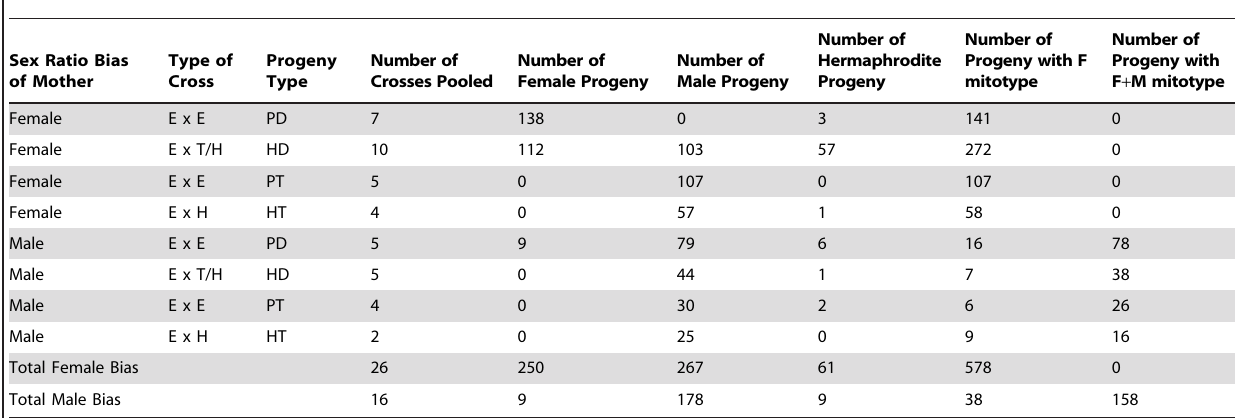
Table 4. Summary Showing Sex Ratio and Mitotype Content of Progeny Pooled by Cross